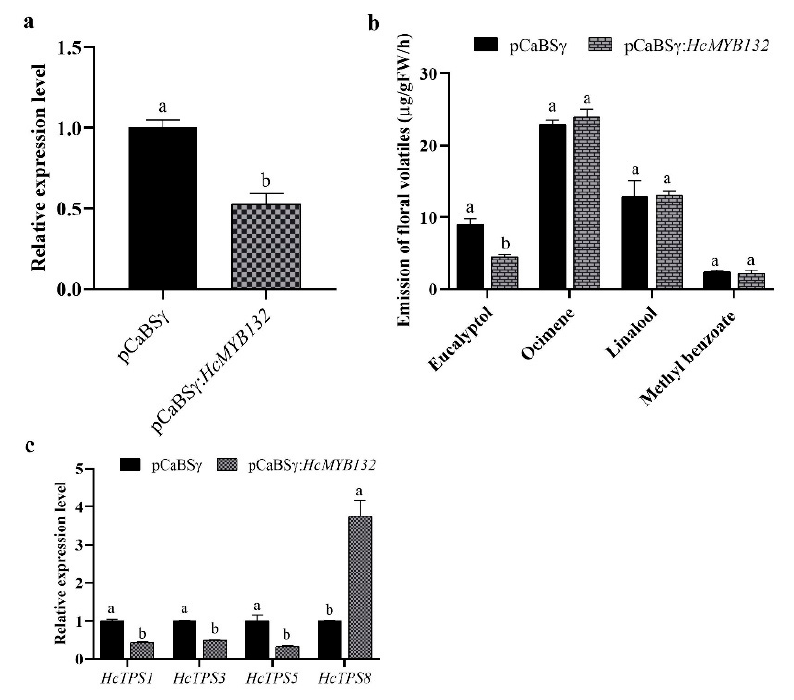
Figure 5. Suppression of HcMYB132 in H. coronarium flowers. ( a ) RT-qPCR assay of HcMYB132 transcript levels in HcMYB132 -silenced and control flowers; ( b ) GC-MS analysis of floral volatiles in HcMYB132 -silenced and control flowers; ( c ) transcript levels of key structural genes in HcMYB132 -silenced and control flowers. Data are shown as ± SEM of three to five repeats. Lowercase letters represent statistically significant differences in LSD test ( p < 0.01).